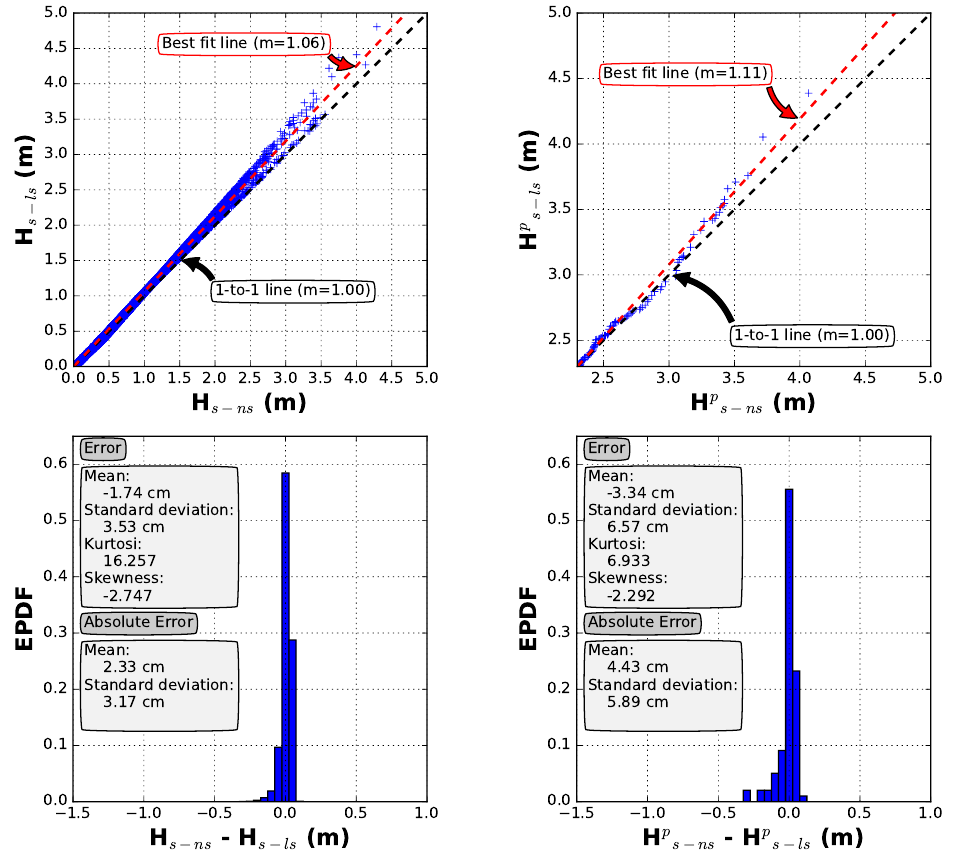
Figure 3. Nearshore wave parameters. ( Left panels ) Statistical analysis of the whole time series of nearshore significant wave height estimated by using national-scale data ( H s − ns ) and local-scale data ( H s − ls ); ( right panels ) statistical analysis of the percentiles of the maximum significant wave height of sea storms identified by a threshold equal to 2.3 m when national-scale data ( H p s − ns ) and local-scale data ( H p ) are used; ( upper panels ) scatter plots of significant wave height (either the s − ls whole time series or the maximum of each sea storm) estimated by using national-scale and local-scale data; ( lower panels ) Empirical Probability Density Function (EPDF) of the difference of the significant wave height (either the whole time series or the maximum of each sea storm) estimated by using national-scale and local-scale data (synthetic information is reported in each